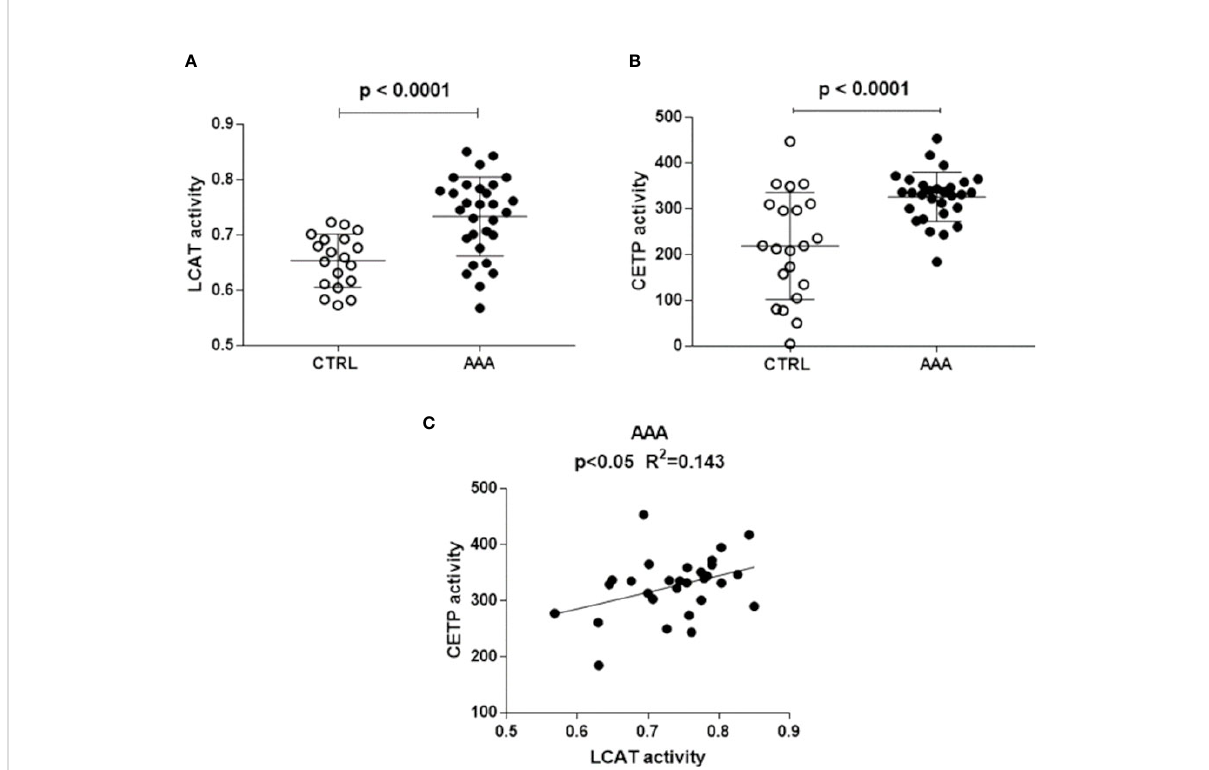
FIGURE 1 LCAT and CETP activity in AAA and non AAA control patients. LCAT and CETP activity is shown in panels (A, B) . Mean and SD for each group are reported. Unpaired two-tailed Student ’ s t-test for parameters with normal distribution was used. The signi fi cant relationship between LCAT and CETP activity, found only in AAA patients by linear regression analysis, is shown in panel (C)